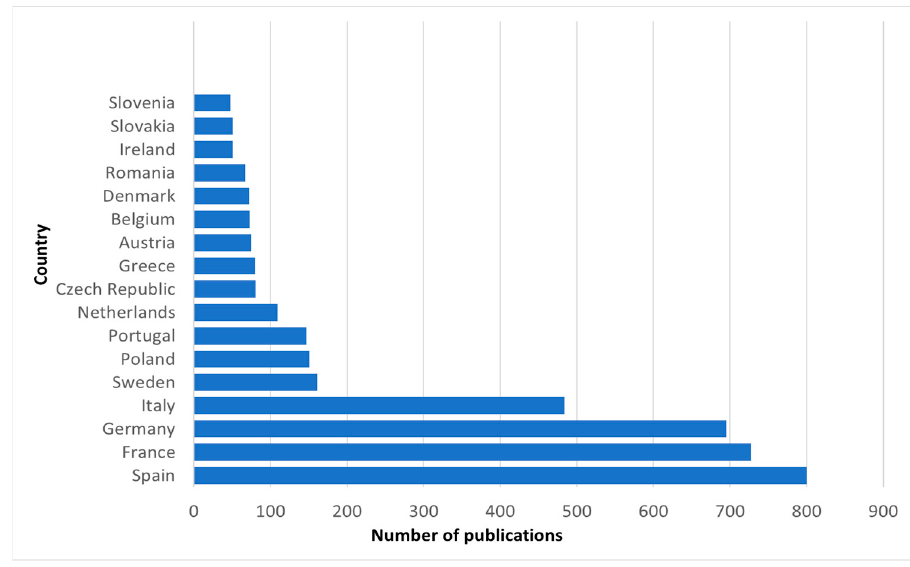
Figure 8. The number of publications in the field of TES materials field by country, just within EU.